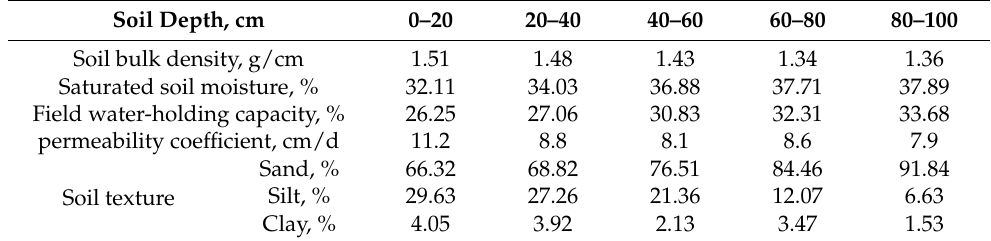
Table 1. Soil physical properties of the experimental field.